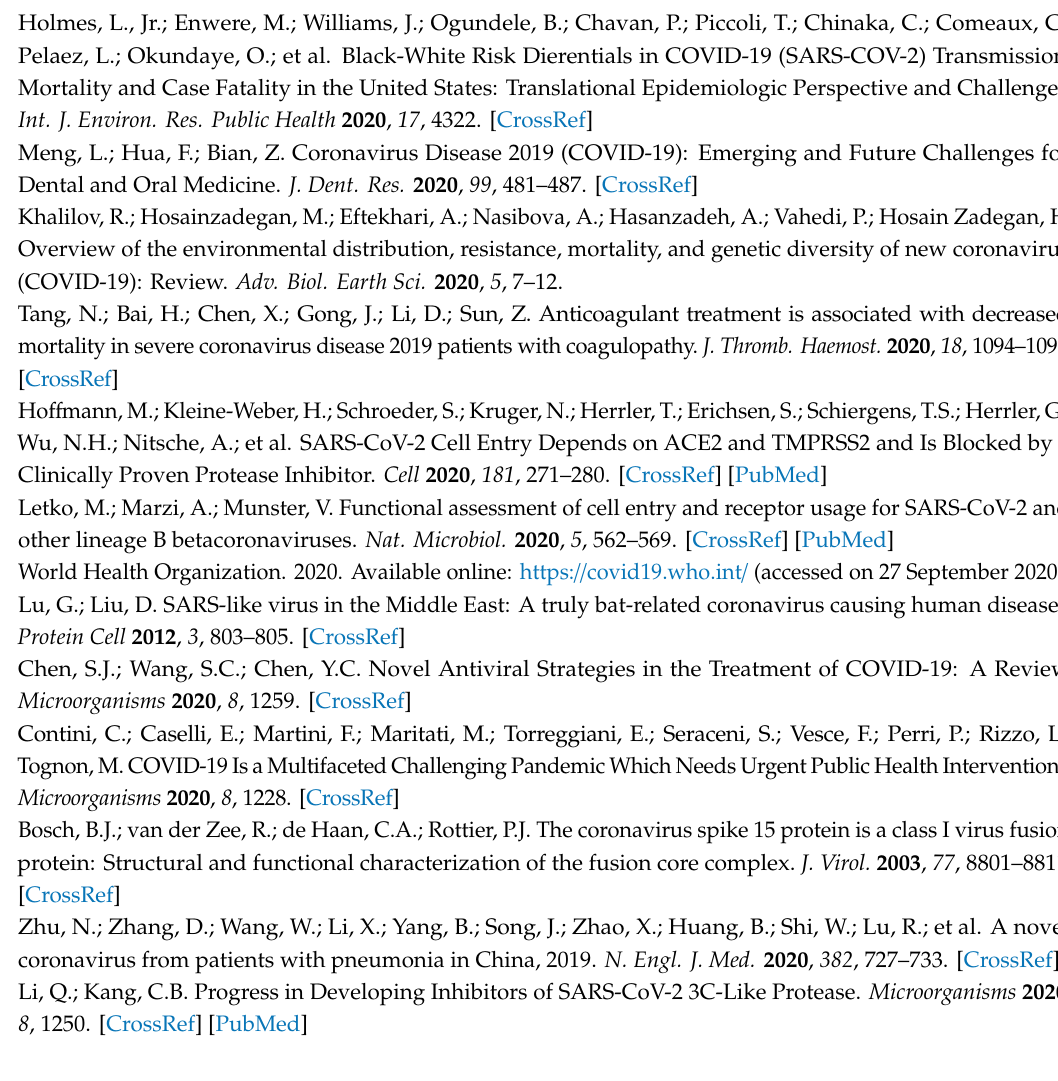
of favipiravir binding mode with receptor binding site of SARS-CoV-2 S protein (6LZG + favipiravir + nicotine); Figure S3: 2D representation of nicotine binding mode with receptor binding site of SARS-CoV-2 S protein (6LZG + favipiravir + nicotine); Figure S4: 2D representation of ribavirin binding mode with receptor binding site of SARS-CoV-2 S protein (6VW1 + ribavirin + ca ff eine); Figure S5: 2D representation of ca ff eine binding mode with receptor binding site of SARS-CoV-2 S protein (6VW1 + ribavirin + ca ff eine); Table S1: Selected drug compounds with S protein (RBD) and ACE2